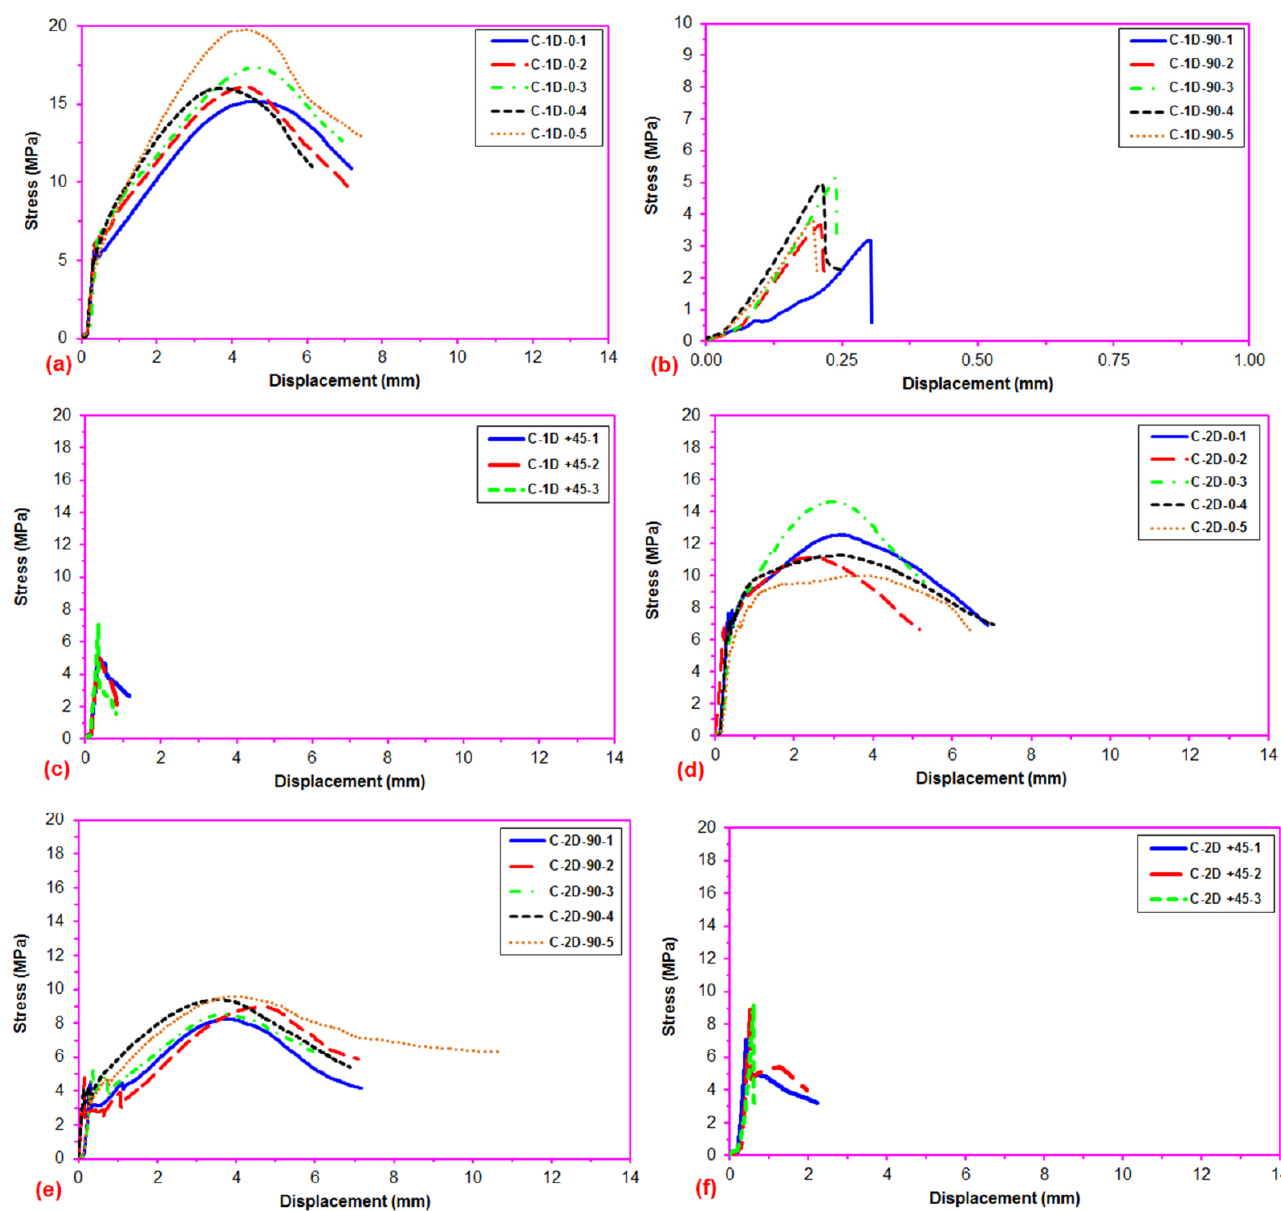
Figure 7. Stress-displacement curves of uniaxial and biaxial 3D concrete composites in the four-point flexural test. ( a ) C-1D at 0 degree flexural test; ( b ) C-1D at 90 degree flexural test; ( c ) C-1D at +45 direction flexural test; ( d ) C-2D at 0 degree flexural test; ( e ) C-2D at 90 degree flexural test; and ( f ) C-2D at +45 direction flexural test.